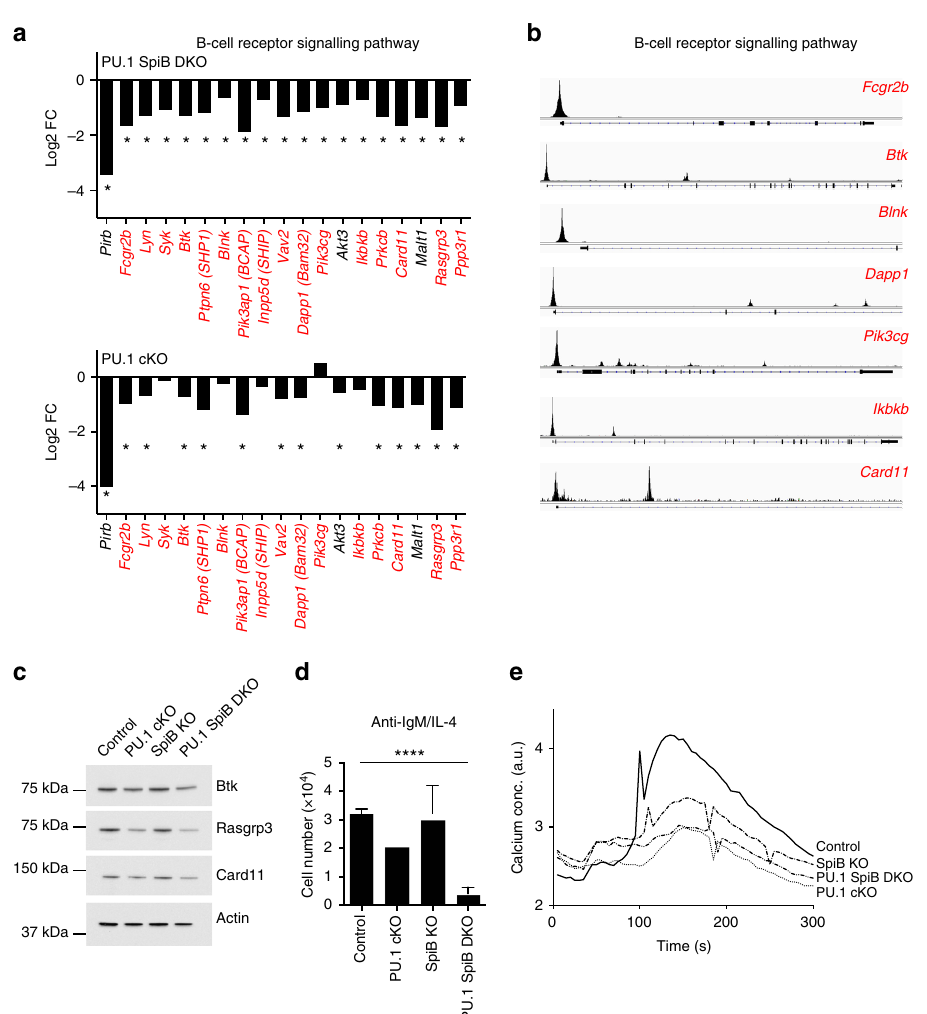
Fig. 6 PU.1 and SpiB maintain expression of multiple BCR components. a Gene expression (from Fig. 5) for the indicated genotype is plotted as the mean fold change (log 2 , from 2 experiments) relative to the expression in the control genotype. *Indicates genes that are DE relative to controls (de fi ned as log 2 fold change > 0.6-fold, log 2 RPKM (reads per kilobase of exon model per million mapped reads) > 0, P < 0.15). b PU.1 ChIPseq identi fi es promoter-binding sites for PU.1 in many components of the BCR signaling pathway. Gene structures are shown below. Gene names in a , b with PU.1 peaks ( P < 10 − 6 ) are indicated in red. c Lysates were generated from activated B cells (cultured for 48 h in CD40 L + IL-4) of the indicated genotype. Western blotting was performed for the indicated proteins. Actin serves as a control for protein loading. Data in b , c are representative of two experiments each. d Loss of PU.1 and SpiB leads to decreased viability in response to BCR signaling. Resting lymph node B cells from mice of the indicated genotype were labeled with CTV and cultured in the presence of anti-IgM+ IL-4 for 3d before fl ow cytometric analysis. The number of live cells is plotted for each genotype examined. Data are the mean ± s.d. for three independent experiments. P -values compare the indicated samples (two tailed t -test). **** P < 0.0001. e Resting B cells of the indicated genotype were cultured with CD40 L + IL-4 for 48 h before being washed and rested for one hour. Cells were then loaded with Indo-1 AM before basal fl uorescence was measured for 30 s. Anti-IgM was then added and fl uorescence changes recorded for an additional 2.5 min. Results are presented as arbitrary units of changes in fl uorescence ratio over time. Data are representative of two